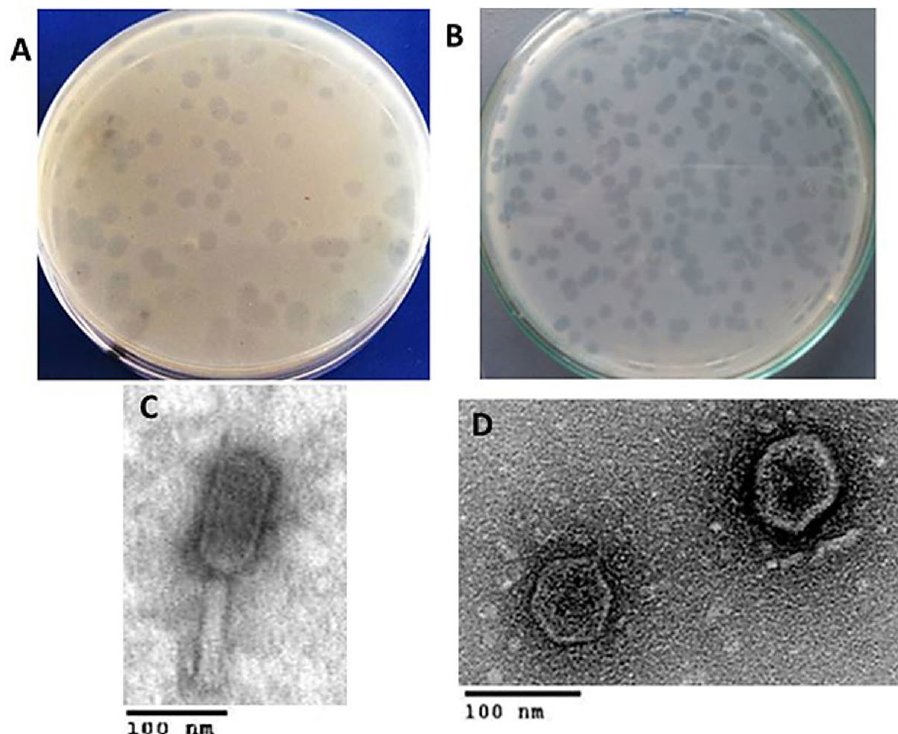
Fig. 1. Plaques phenotypes and TEM morphology of the isolated phages. (A-B) Images of bacterial plaques formed by the isolated phage in top-agar lawns of S. aureus EG-AE3 and E. faecalis EF01, plaque appearance was detected and imaged after culturing 48 h on their hosts. (C-D) TEM micrographs of phages vB_SauM-EG-AE3 and vB_EfaP- Ef01 were negatively stained with 0.2% uranyl acetate as described in Materials and Methods. Scale bar= 100 Table 1. Antibiotic sensitivity pattern of the isolated dental caries bacteria against a selection of twelve antibiotics Bacteria F